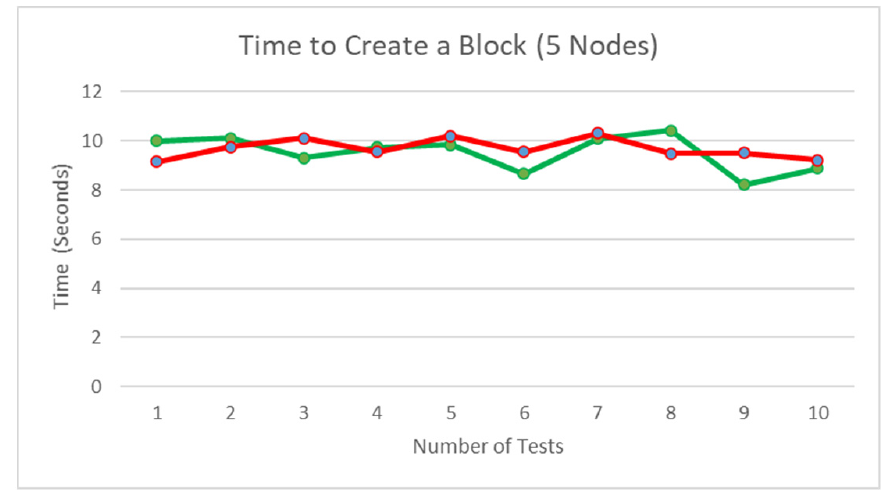
Figure 32. Time taken to create a block with 5 running